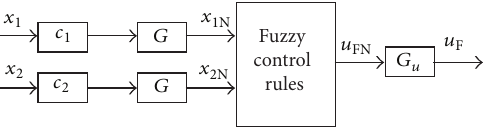
Figure 1: The proposed fuzzy logic controller.